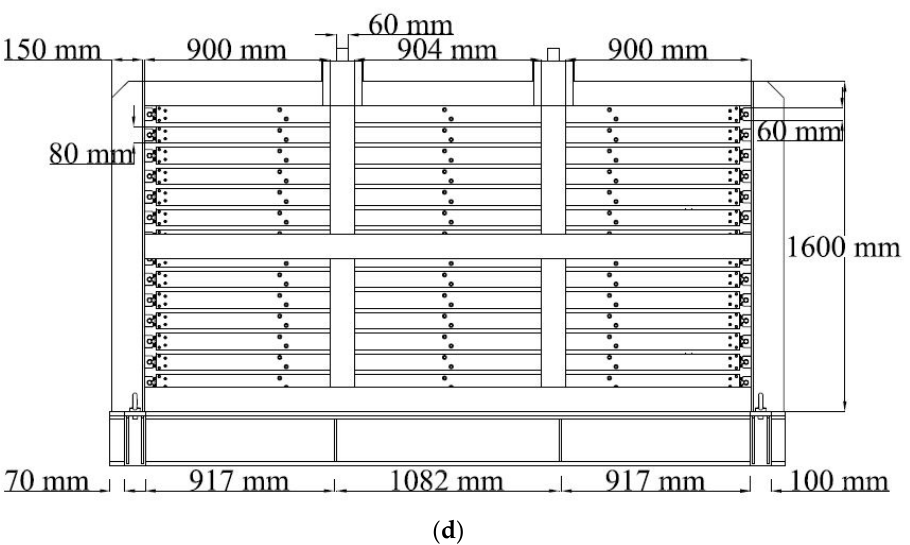
Figure 22. Profile views of the laminar shear box: ( a ) back view; ( b ) right view; ( c ) front view; ( d ) left view.